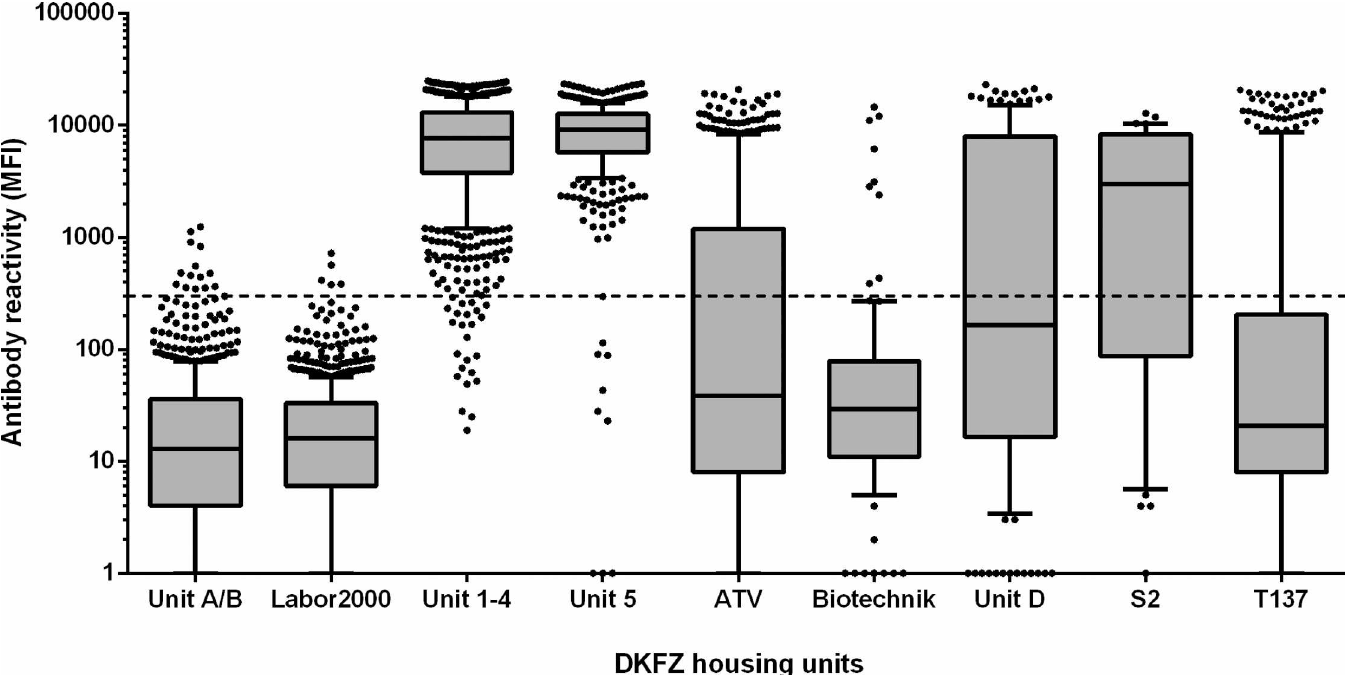
Fig 4. Comparison of murine astrovirus specific antibody detection in DKFZ breeding and experimental units by multiplex serology. Box plot of net MFI values (S3 Dataset) are shown. Boxes are delimitedby the first and third quartile(IQR, Q1-Q3) and represent 50% of data. Whiskers show the 10 th and 90 th percentiles, respectively. The line inside the boxes represents the median.The horizontal dotted line indicatesthe antigen-specific cut-off value. The distributionof antibody reactivities in terms of MFI values ranges from units without virus circulation(units A/B, Labor2000), units with a low to medium sero- prevalence (ATV, S2, T137, Biotechnik and unit D) to units where most animalshad been in contact with the virus (units 1–4 and 5).